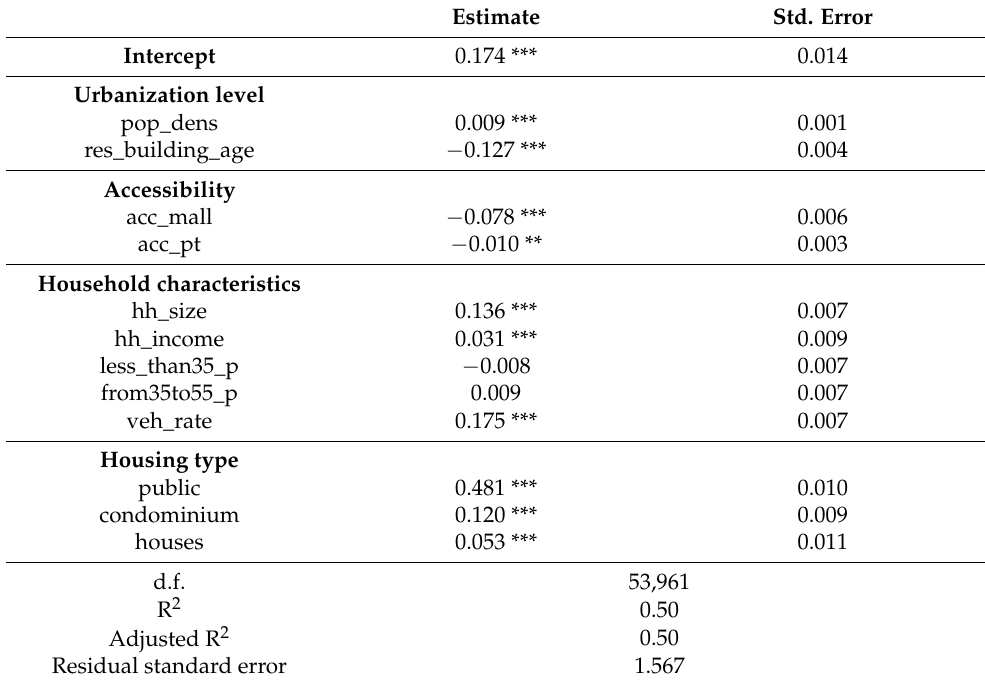
Table 4. Linear regression